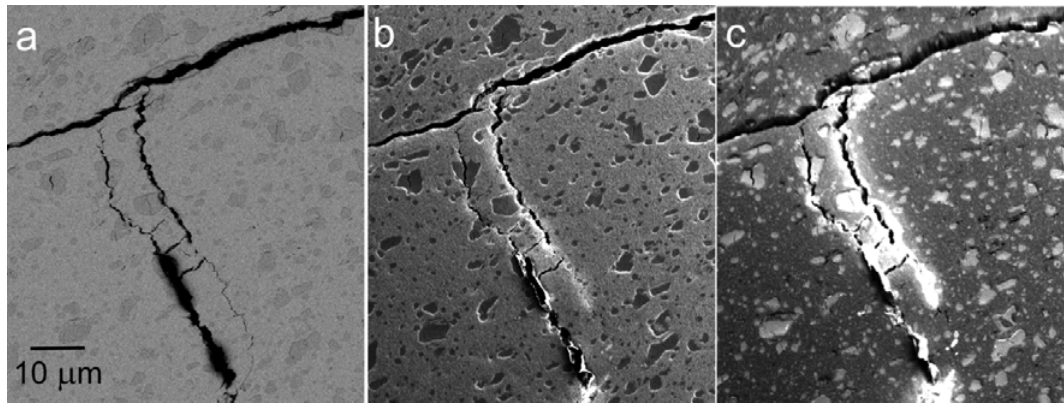
Figure 13. The X210Cr12 steel deformed with severe torsion and pressure (the TT deformation) at 350  C, showing vanadium-chromium precipitates. ( a ) Standard BSE image at 7 keV; ( b ) Sample immersed in 1 kV/mm field, landing energy 1 keV; ( c ) Sample immersed in 1.2 kV/mm field, landing energy 15 eV.